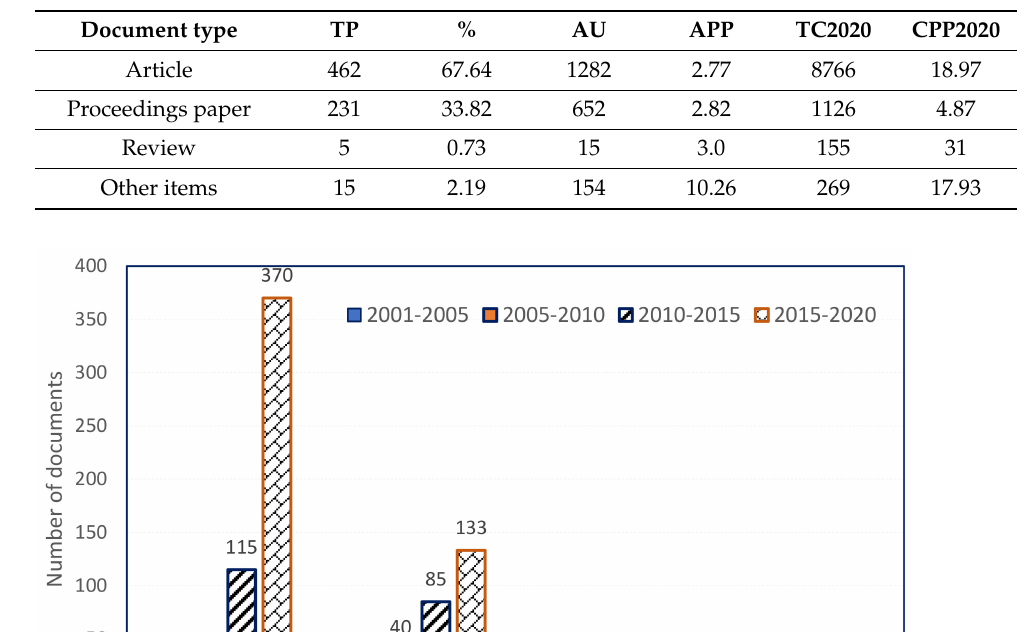
Table 9. Citation analysis based on document type.